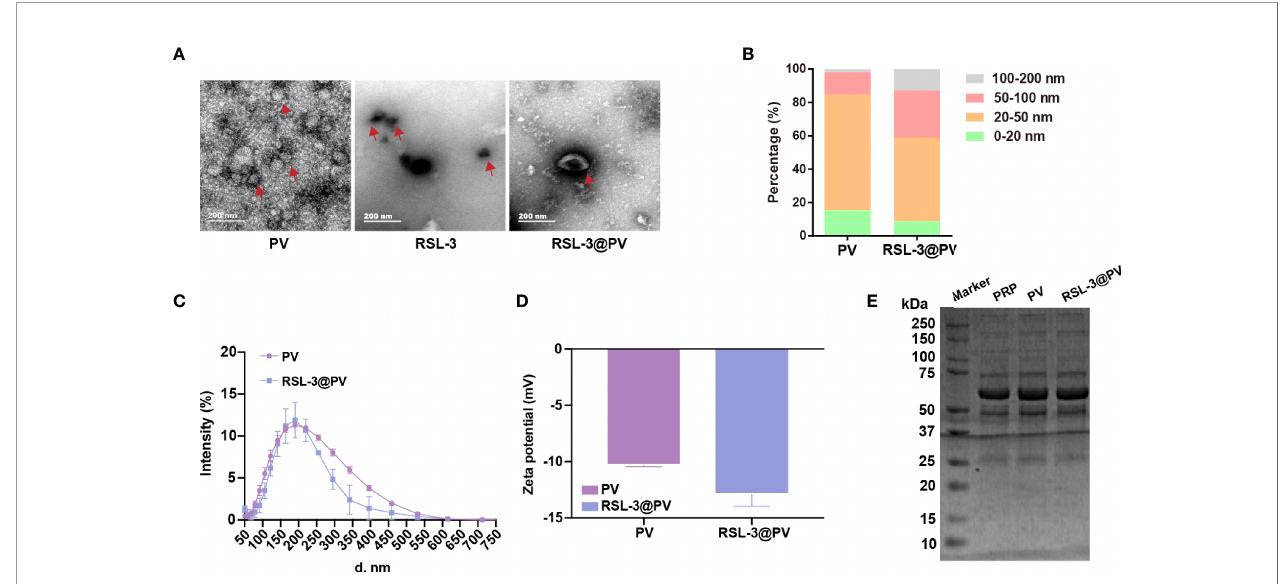
FIGURE 1 | Characterization of RSL-3@PVs. (A) TEM images of PV, RSL-3, and RSL-3@PVs. Scale bars: 200 nm. (B, C) Hydrodynamic diameters distribution of PV and RSL-3@PVs. (D) Zeta potentials of PV and RSL-3@PVs. (E) SDS-PAGE analysis of the platelet-related proteins in PRP, PV, and